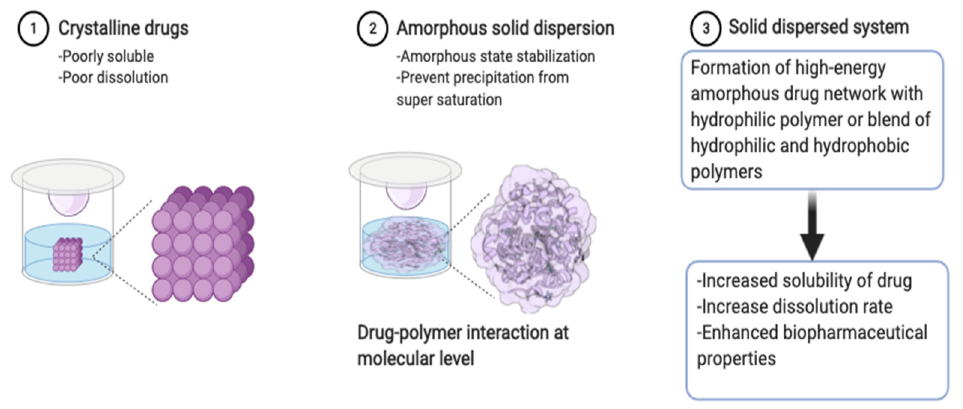
Figure 4. Schematic illustration of solid dispersion process.